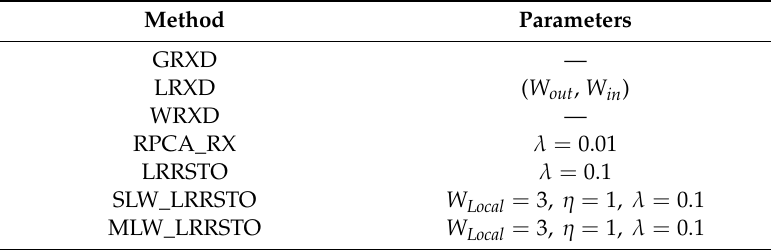
Table 2. Parameters of the different detection methods.